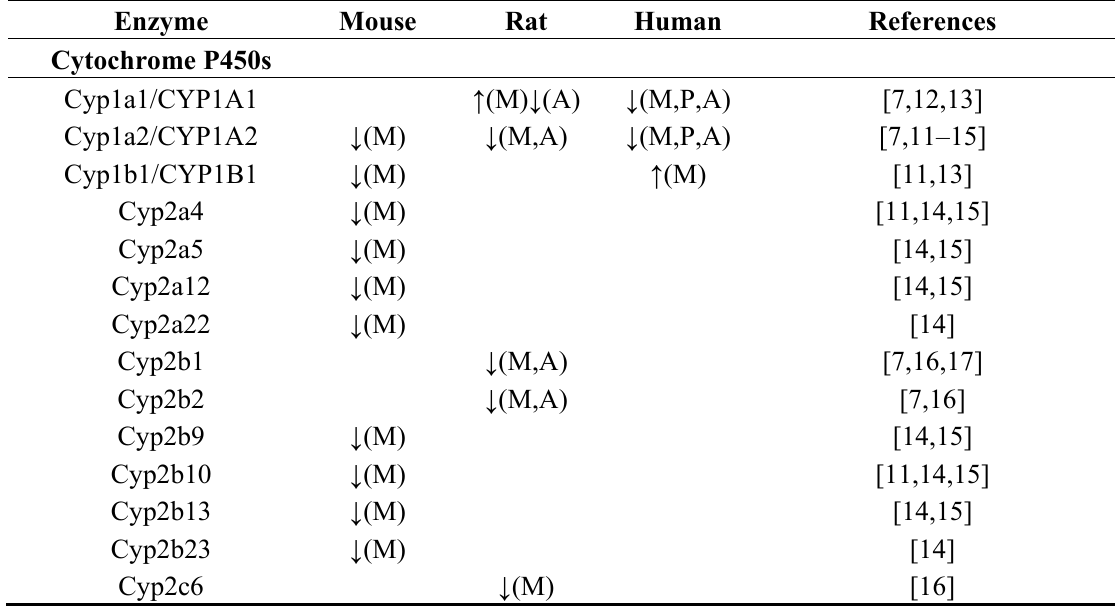
Table 2. Phase I metabolism (cytochrome P450) in rodent and human fetal livers. 1